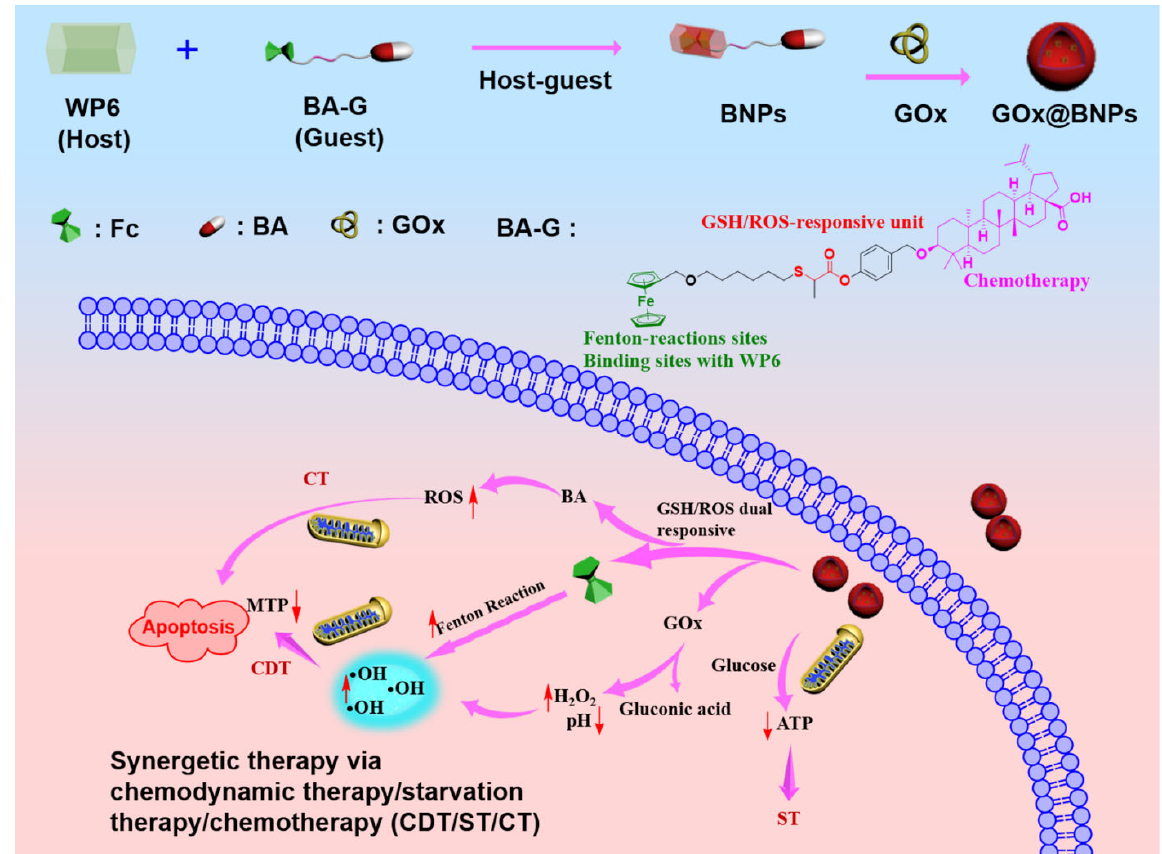
Scheme 1. Schematic illustration of the preparation of supramolecular nanoparticles and their GSH/ROS dual ‐ responsive drug release and anti ‐ proliferative mechanisms against A549 cancer cells.